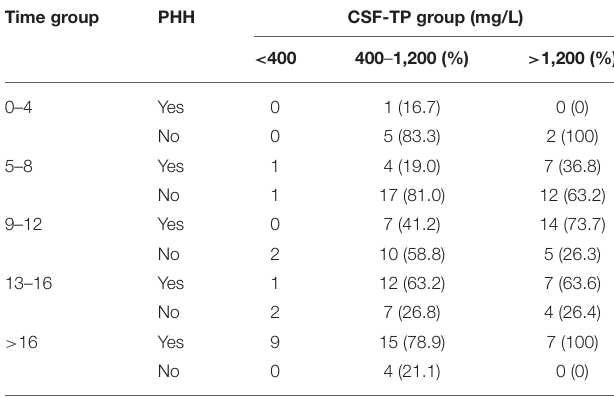
TABLE 4 | PHH after grouping CSF-TP and time